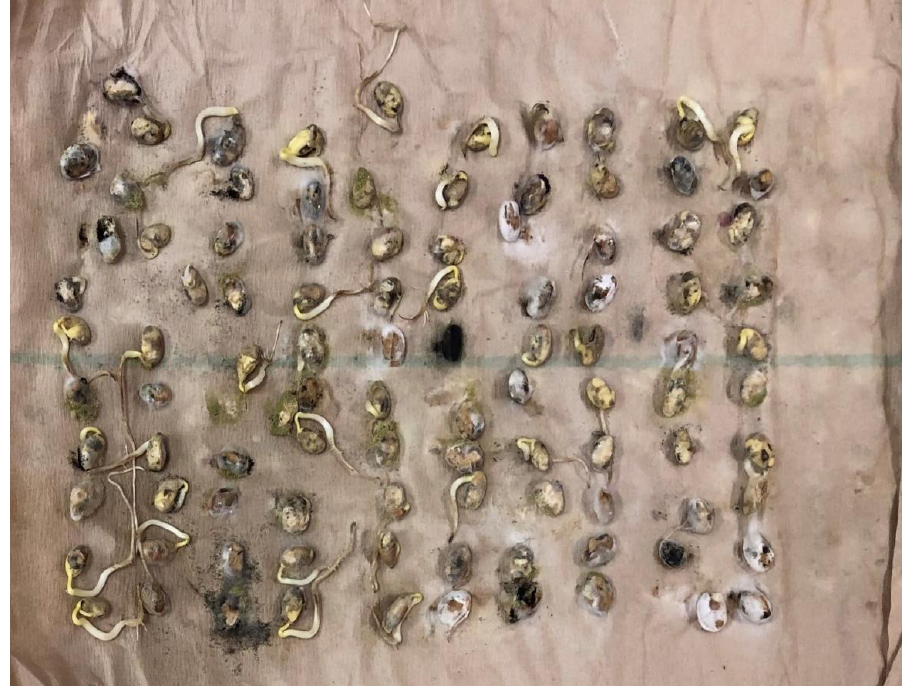
Figure 2. Seven days after initiation of germination and seedling vigor test. Incubators set at 25 °C on continuous light. An image representing seedling germination and vigor of non-infected (non-symptomatic) soybean seedlings. The field experiment was conducted in 2019 at the Delta Research and Extension Center in Stoneville, MS.